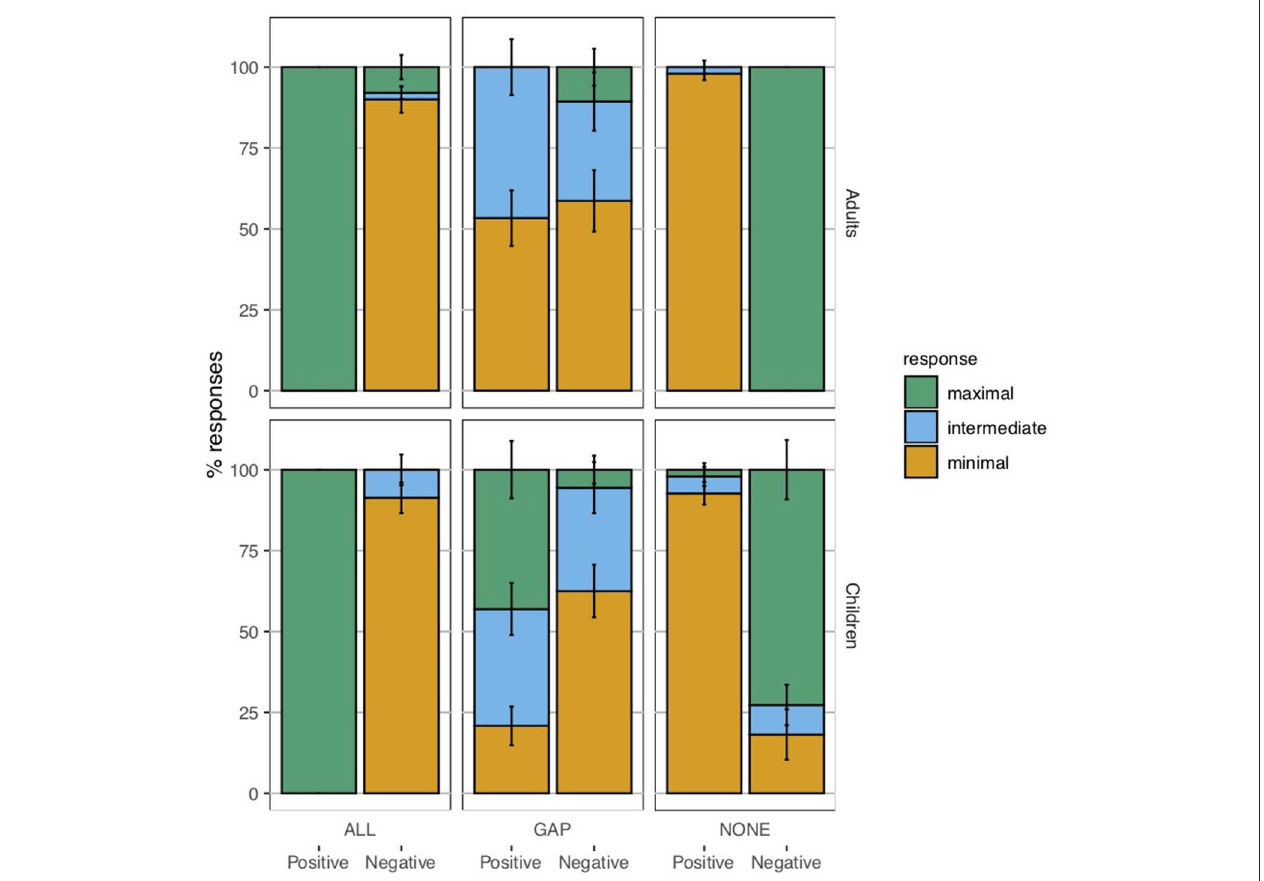
FIGURE 13 | Percentages of the reward types given in the definite les “the” conditions. True controls corresponded to positive plural definite descriptions of ALL contexts and negative plural definite descriptions of NONE contexts. False controls corresponded to positive plural definite descriptions of NONE contexts and negative plural definite descriptions of ALL contexts. Homogeneity targets corresponded to plural definite descriptions of GAP contexts.